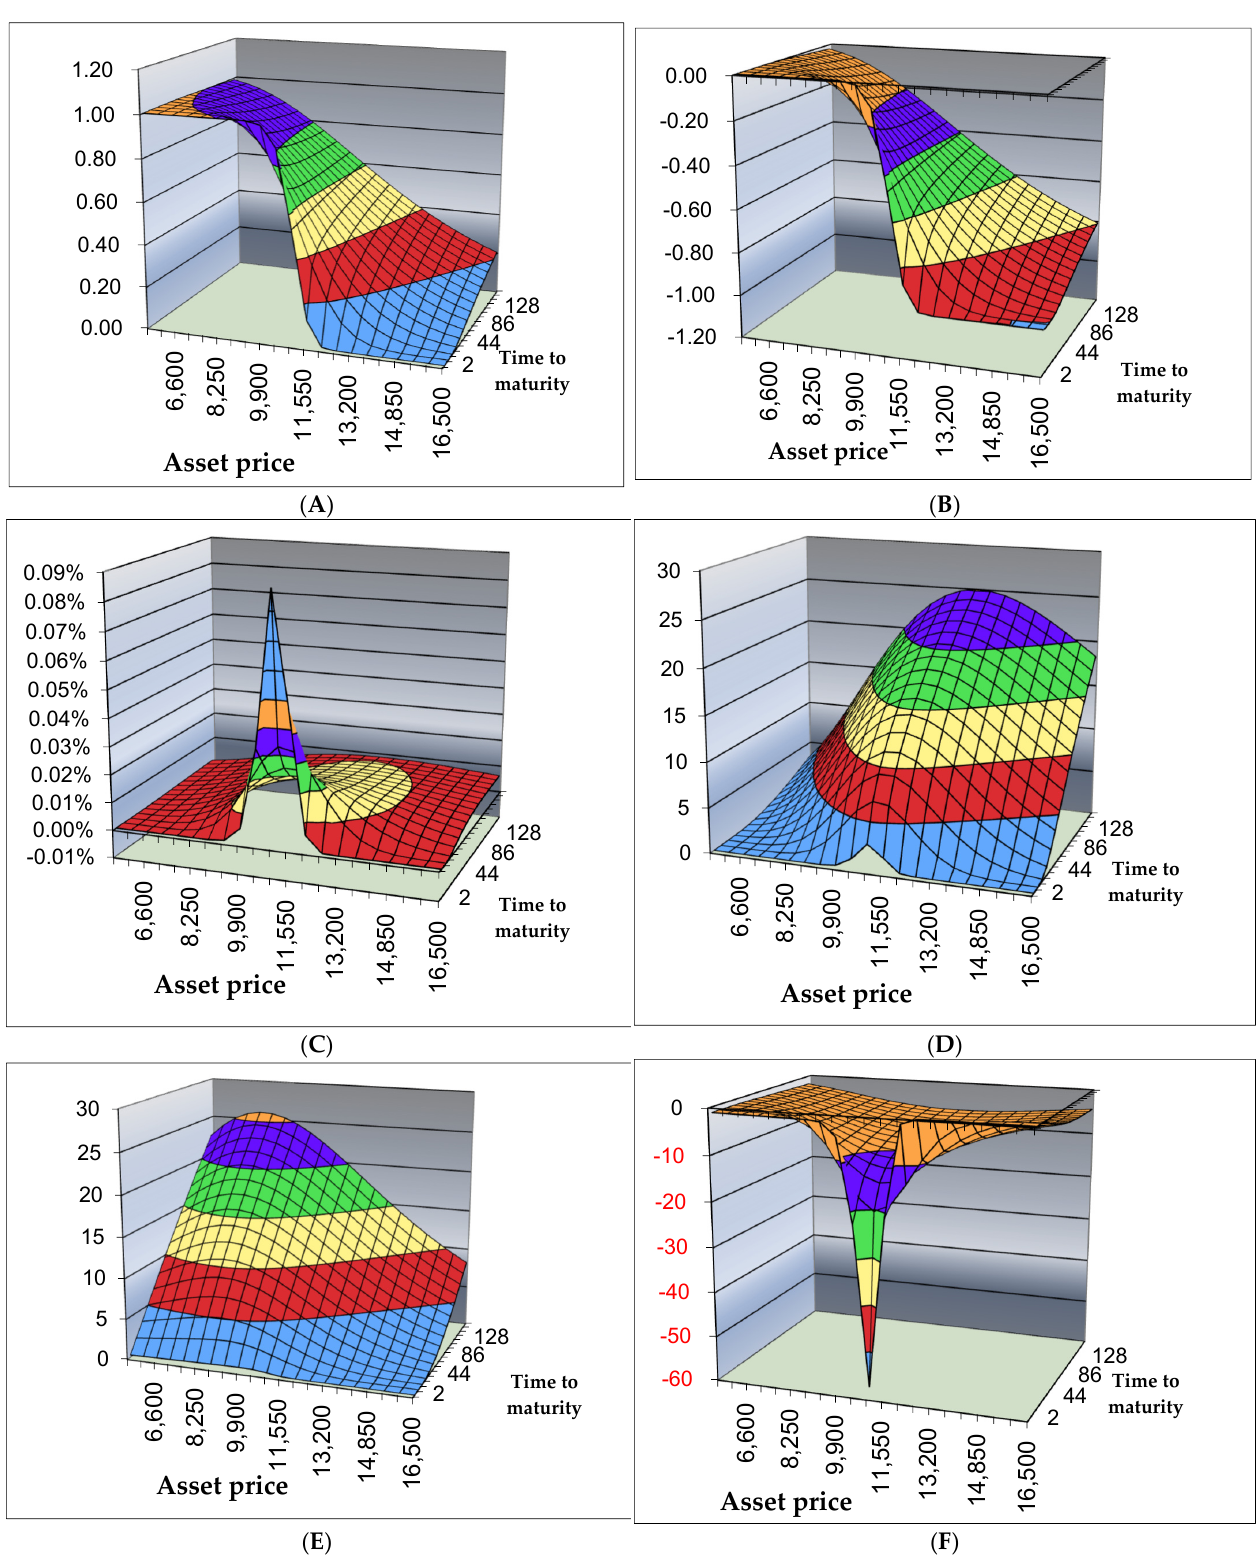
Figure 4. ( A ) The surface of Call options’ Delta; ( B ) The surface of put options’ Delta; ( C ) The surface of call and put options’ Gamma; ( D ) Implied volatilities for call and put options’ Vega; ( E ) Volatility surface of call options’ Rho on Bitcoin price; ( F ) Theta of European call options.